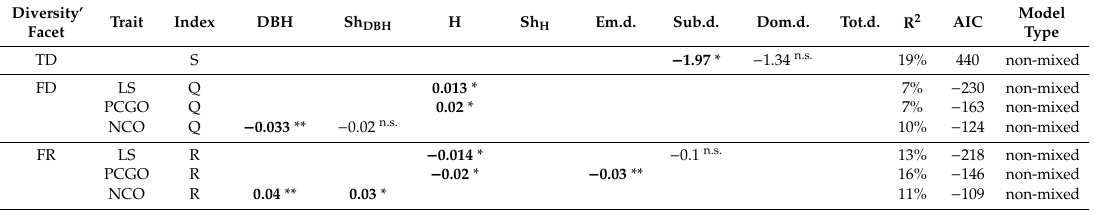
Table 2. Relationship between the di ff erent facets of biodiversity (TD = taxonomic diversity; FD = functional diversity; R = functional redundancy) and the structural features analysed for the Sibillini and Duchessa montane beech forests in the Central Apennines in Italy. Species richness (S) is the measure of taxonomic diversity (TD); Rao’s quadratic entropy raw (Q) is the measure of functional diversity (FD), while combined with Simpson (R) is the measure of functional redundancy (FR) for the clonal traits considered in this study (LS: lateral spread; PCGO: persistence of clonal growth organs; NCO: number of clonal o ff spring). We report the results of multiple regression models, the coe ffi cient values, the significance of each predictor, the R 2 values and AIC of each model. Diversity’ 2 AIC Model Facet Trait Index DBH Sh DBH H Sh H Em.d. Sub.d. Dom.d. Tot.d. R Type − 1.97 * − 1.34 n.s. 19% 440 non-mixed FD LS Q 0.013 * 7% − 230 non-mixed PCGO Q 0.02 * 7% − 163 non-mixed NCO Q − 0.033 ** − 0.02 n.s. 10% − 124 non-mixed FR LS R − 0.014 * − 0.1 n.s. 13% − 218 non-mixed PCGO R − 0.02 * − 0.03 ** 16% − 146 non-mixed NCO R 0.04 ** 0.03 * 11% − 109 non-mixed DBH = mean diameter of standards; H = mean height of standards; Sh DBH = diversity of the diameters of standards; Sh H = diversity of the height of standards; Em.d. = emergent density layer; Sub.d. = subordinate density layer; Dom.d. = dominant density; Tot.d. = total density layer. ** p < 0.01; * p < 0.05; n.s. not significant. Significant results are represented in bold. Model type refers to the model that emerges from the comparison between non-mixed and mixed models according to the AIC